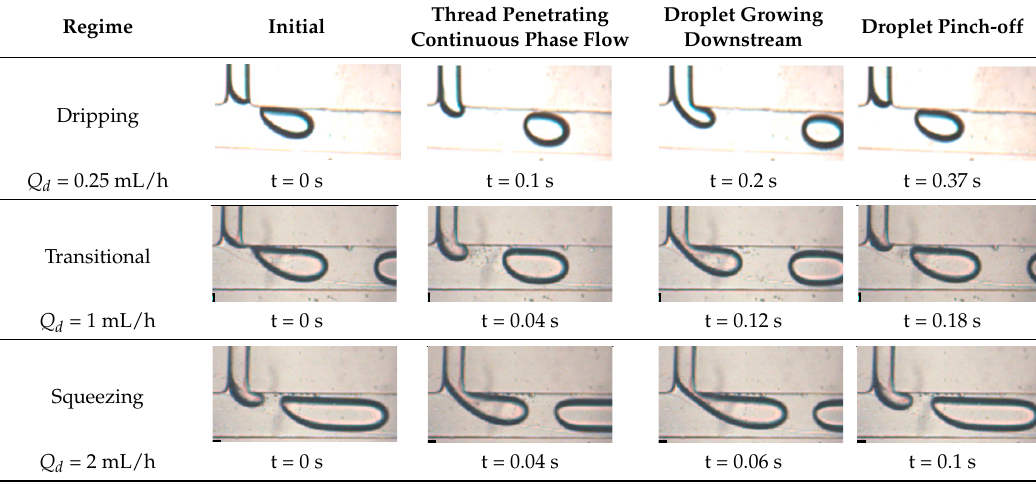
Table 3. Timescale of droplet generation during dripping, squeezing, and the transitional regime at a constant capillary number Ca = 0.0566. The dispersed phase flow rate ( Q d ) is varied, while the continuous phase flow rate ( Q c ) is kept constant.